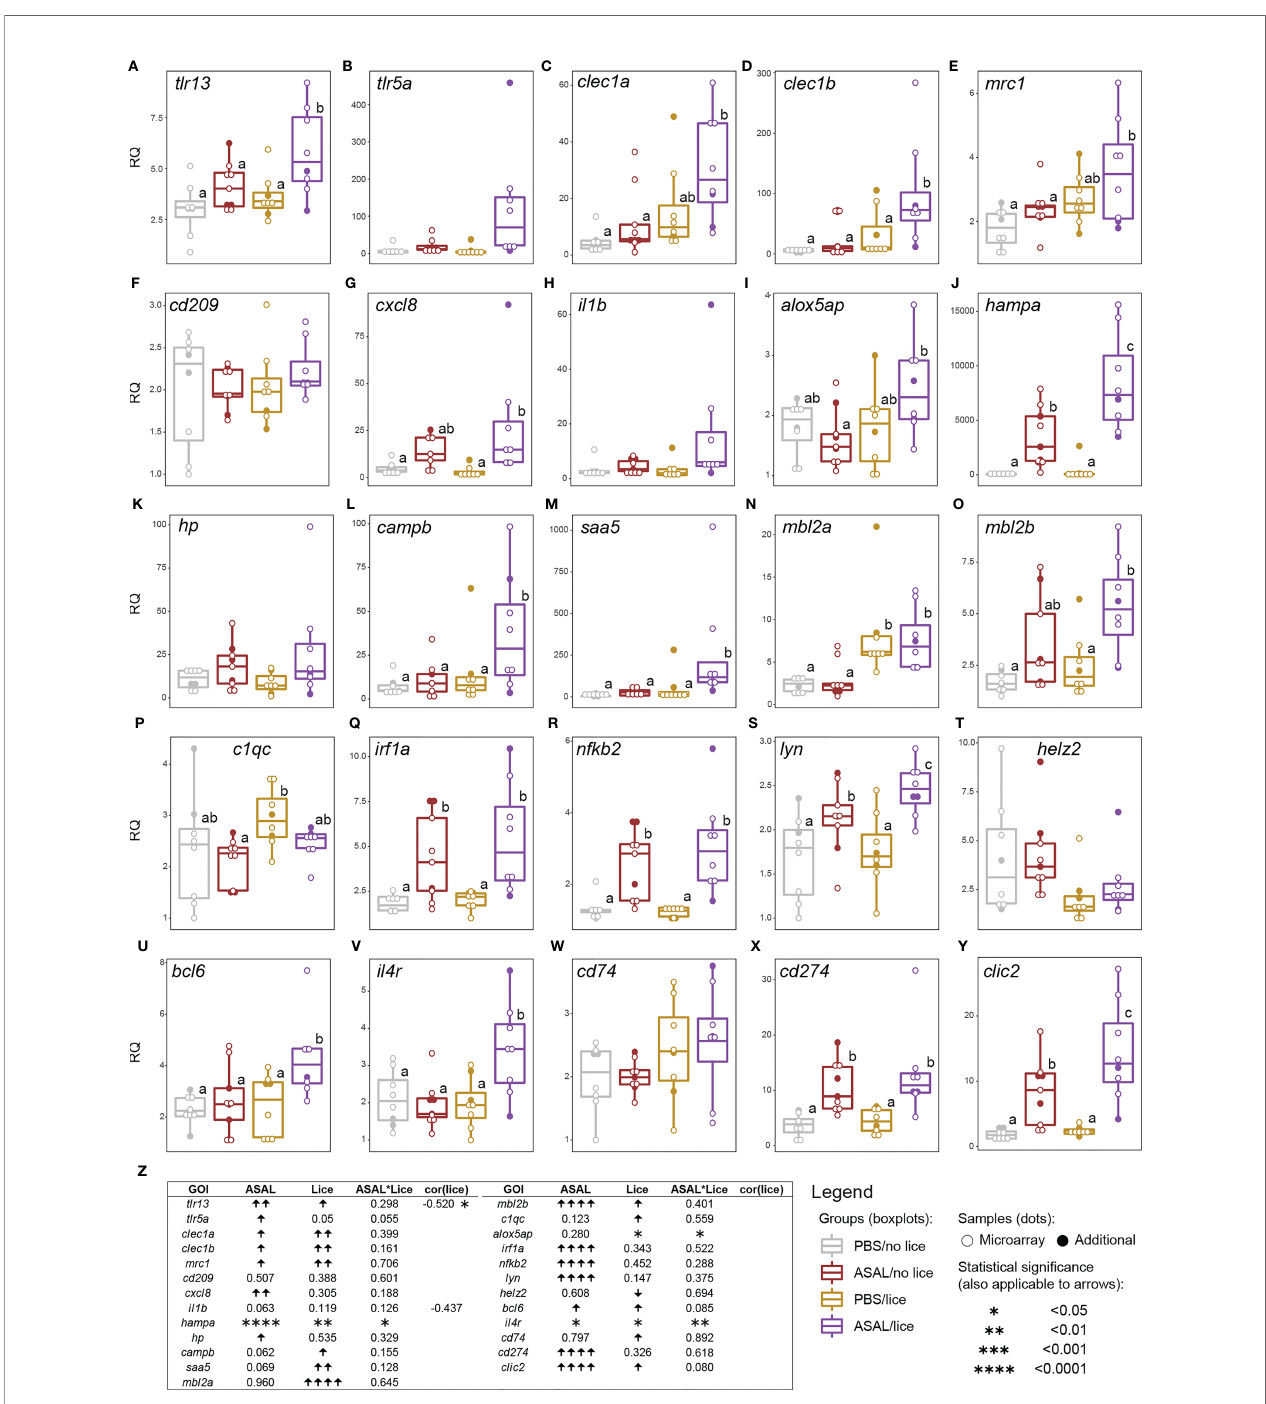
FIGURE 7 | qPCR results of lice, ASAL, and lice+ASAL-responsive genes putatively involved in (A – F) pathogen/damage-associated molecular pattern recognition, (G – I) in fl ammatory responses, (J – P) innate immune responses, (Q – U) transcriptional regulation in innate and adaptive immune responses, and (V – Y) adaptive immunity-related processes. qPCR data are represented with scatter plot/boxplot overlays (n = 8-9 per injection/infection group). The scatter plot differentiates the additional biological replicates included in the qPCR validation (solid dots) from those selected for microarray analysis (empty dots). Lowercase letters indicate signi fi cant differences between groups, as determined by estimated marginal means. (Z) Summary of the results from the generalized linear model (GLM) analysis of the qPCR data and Pearson coef fi cients ( r ) for signi fi cant gene transcript levels and total lice count correlations. Upward and downward arrows indicate signi fi cant up and down-regulation, respectively. Asterisks are used instead of arrows when a signi fi cant lice and ASAL interaction (i.e., lice*ASAL) was detected. Asterisks also indicate a signi fi cant Pearson correlation. The statistical signi fi cance threshold was p < 0.05 for all statistical analyses. il1b ’ s Pearson coef fi cient is indicated due to its closeness to statistical signi fi cance (i.e., 0.05 < p < 0.10) and physiological